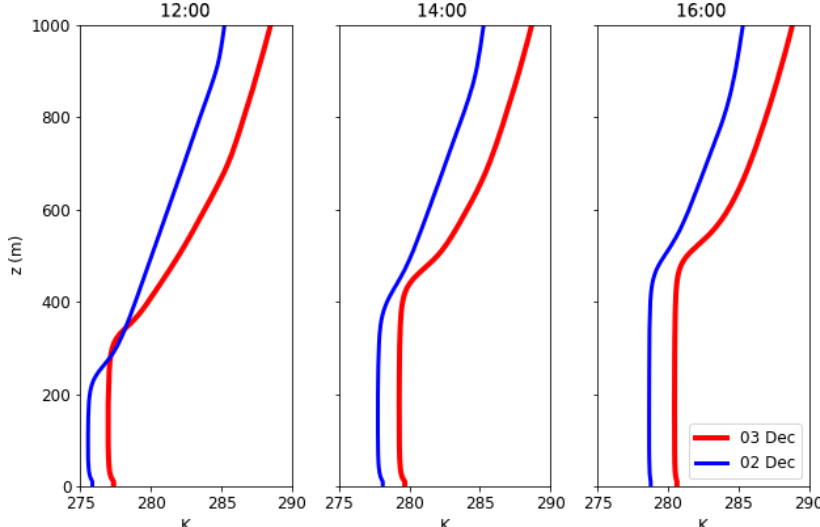
Figure 7. Potential temperature profiles for Met_0312_noaero simulations (red lines) and Met_0212_noaero (blue lines) at 12:00, 14:00 and 16:00LST.